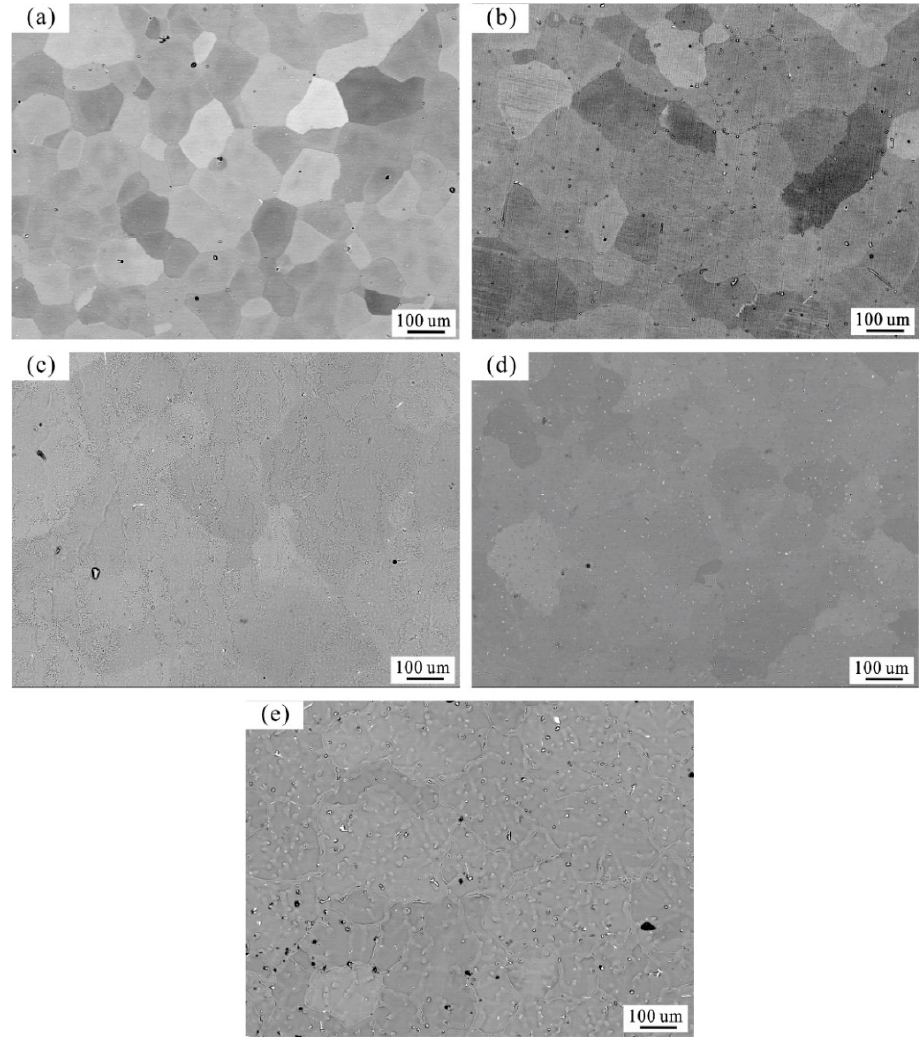
Figure 4. Back scattered electron (BSE) images of the electrolytic polished Mg-3Al- x Mn alloys by electron probe microanalysis (EPMA): ( a ) Mg-3Al, ( b ) Mg-3Al-0.12Mn, ( c ) Mg-3Al-0.21Mn, ( d ) Mg-3Al-0.36Mn, ( e ) Mg-3Al-0.45Mn. The dark spots are shrinkage cavity formed in the solidification process.